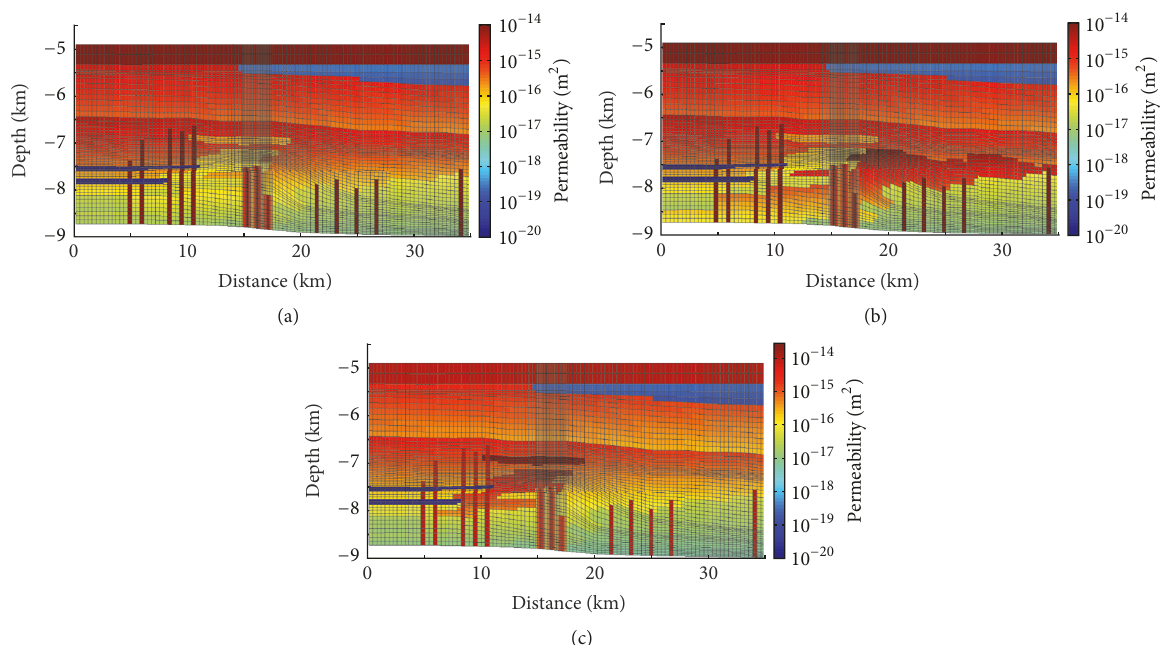
Figure 9: Initial values of horizontal permeability used in simulations for Scenario I (a), Scenario II (b), and Scenario III (c). Note that the permeability was assigned to different stratigraphic and lithologic units based on Figure 3. The lithologic units which are not displayed in Figure 3 are assigned based on the stratigraphic description in Figure